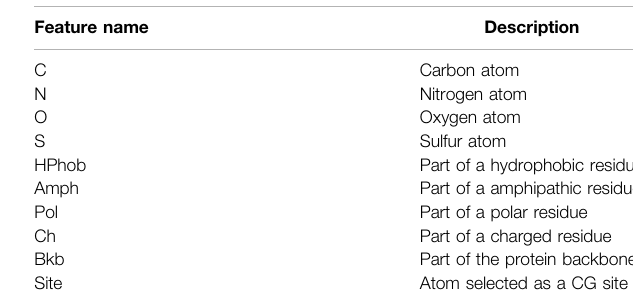
TABLE 2 | Binary features (0/1) used to describe the physicochemical properties of an atom in the protein, i.e., a vertex in the graph representation of the latter. Inthissimplemodel,weonlyprovidetheDGNwiththechemicalnatureoftheatom and of its residue, together with the fl ag Bkb that speci fi es if the atom is part of the backbone of the polypeptide